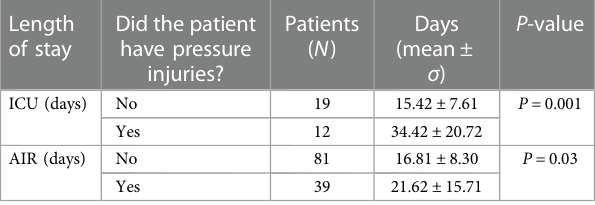
TABLE 2 Lengths of stay in ICU and AIR stay in COVID-19 patients± pressure